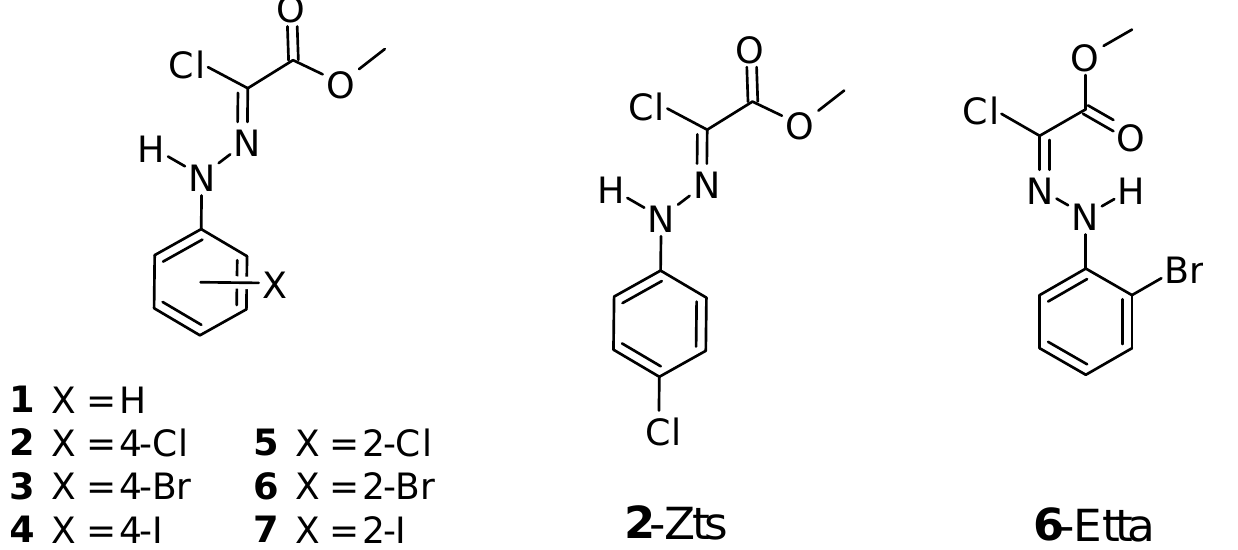
Figure 1. The seven investigated chlorohydrazones and two particular isomers of 2 and 6 .